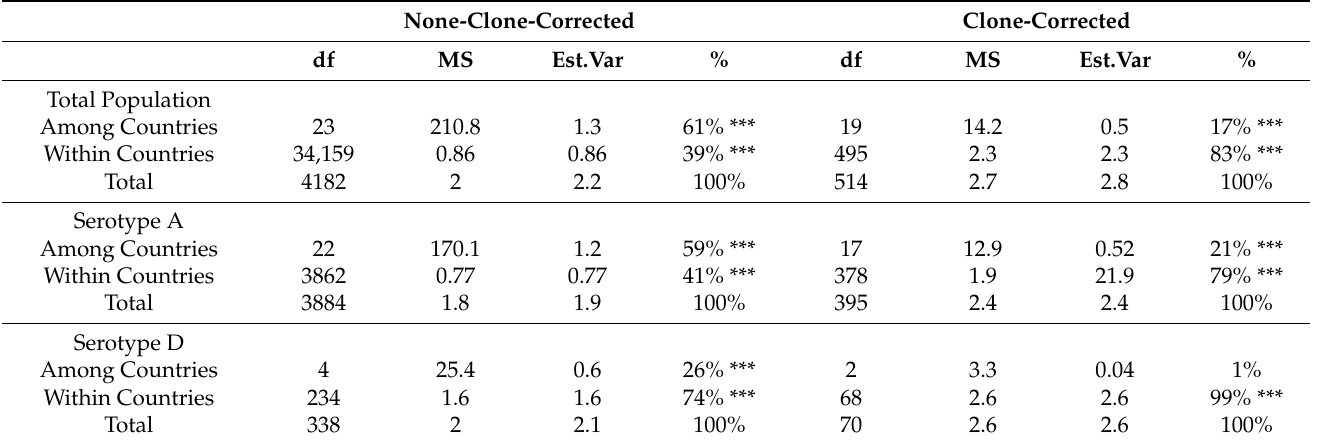
Table 7. Analysis of molecular variance at the country